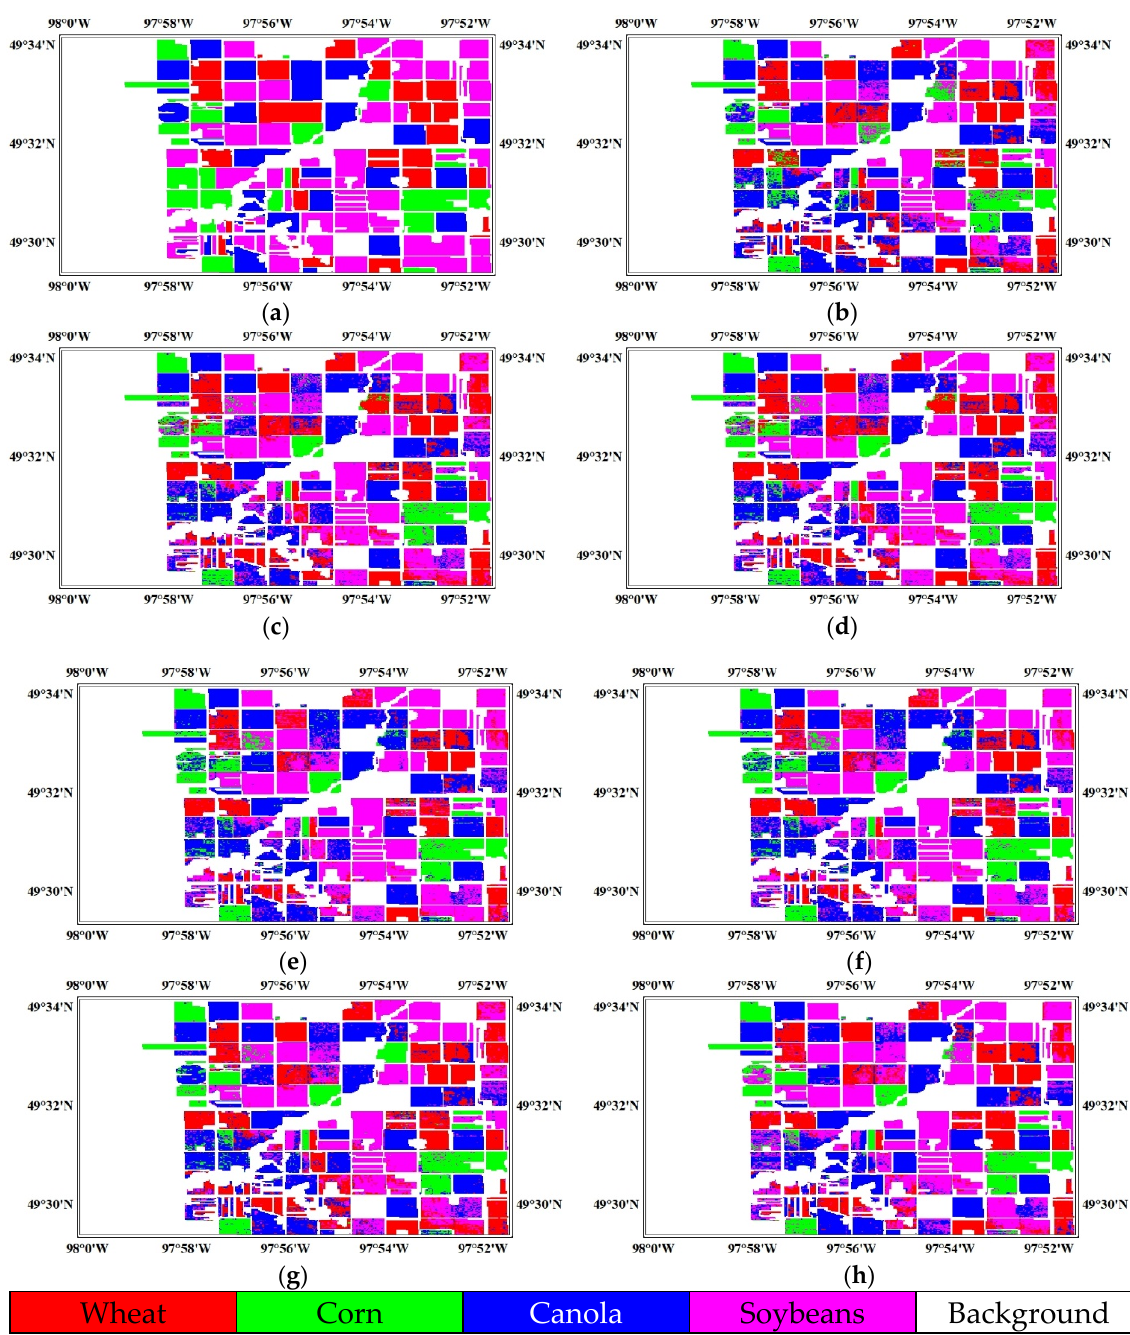
Figure 6. Ground truth map and classification maps in Winnipeg (SD: B -> TD: C), generated by different methods: ( a ) Ground truth; ( b ) DAC; ( c ) TCA+DAC; ( d ) SSTCA+DAC; ( e ) MIDA+DAC; ( f ) SMIDA+DAC; ( g ) SMbDA+DAC; ( h ) WSMbDA+DAC.